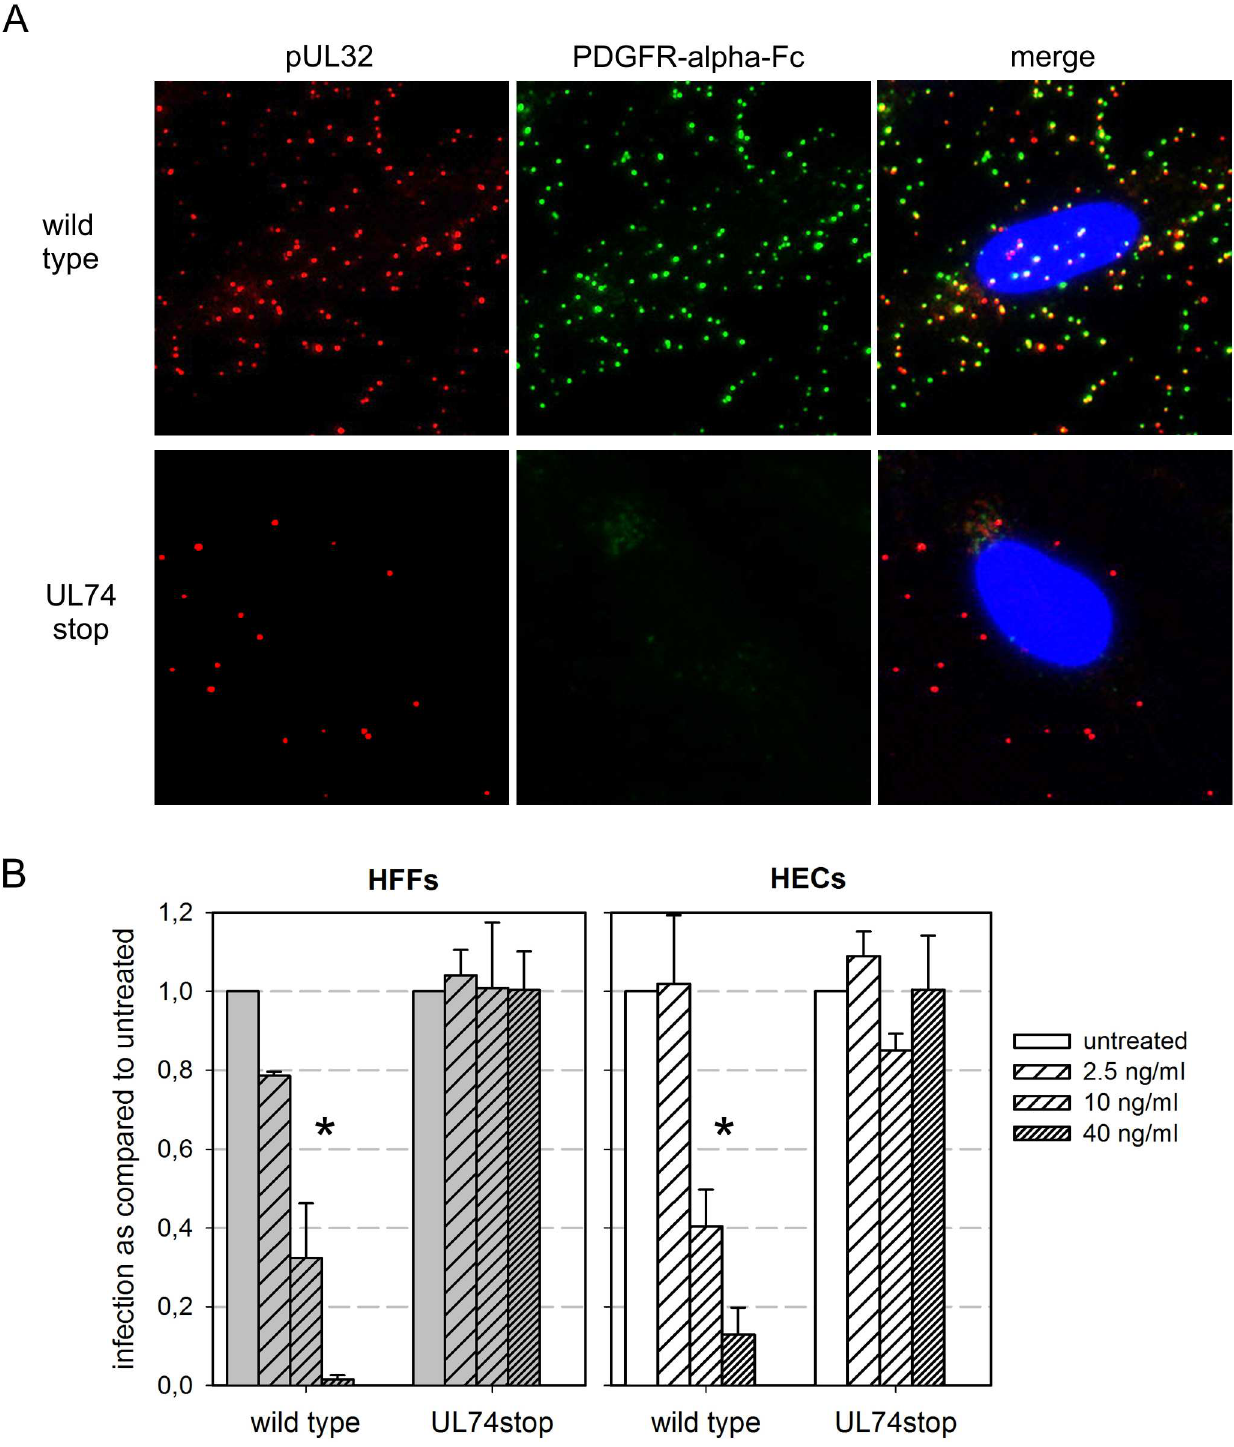
Fig 8. PDGFR-alpha-Fc binds HCMV particles only in the presenceof the gH/gL/pUL74 complex. (A) Virus preparations of strain TB40-BAC4 (wild type) or TB40-BAC4-UL74stopwere pretreated with 500 ng/ml PDGFR-alpha-Fc for two hours at 37˚C. Fibroblasts (HFFs) were then incubatedwith pretreatedvirus on ice followedby immunofluorescence staining for the viral structural protein pUL32(red) and the Fc- fusion part of PDGFR-alpha-Fc (green). (B) Virus preparations were preincubated with variableconcentrations of PDGFR-alpha-Fc for 2h before infectionof HFFs and endothelialcells (HECs). One day postinfection, cells were fixed and stainedby immunofluorescencefor viral